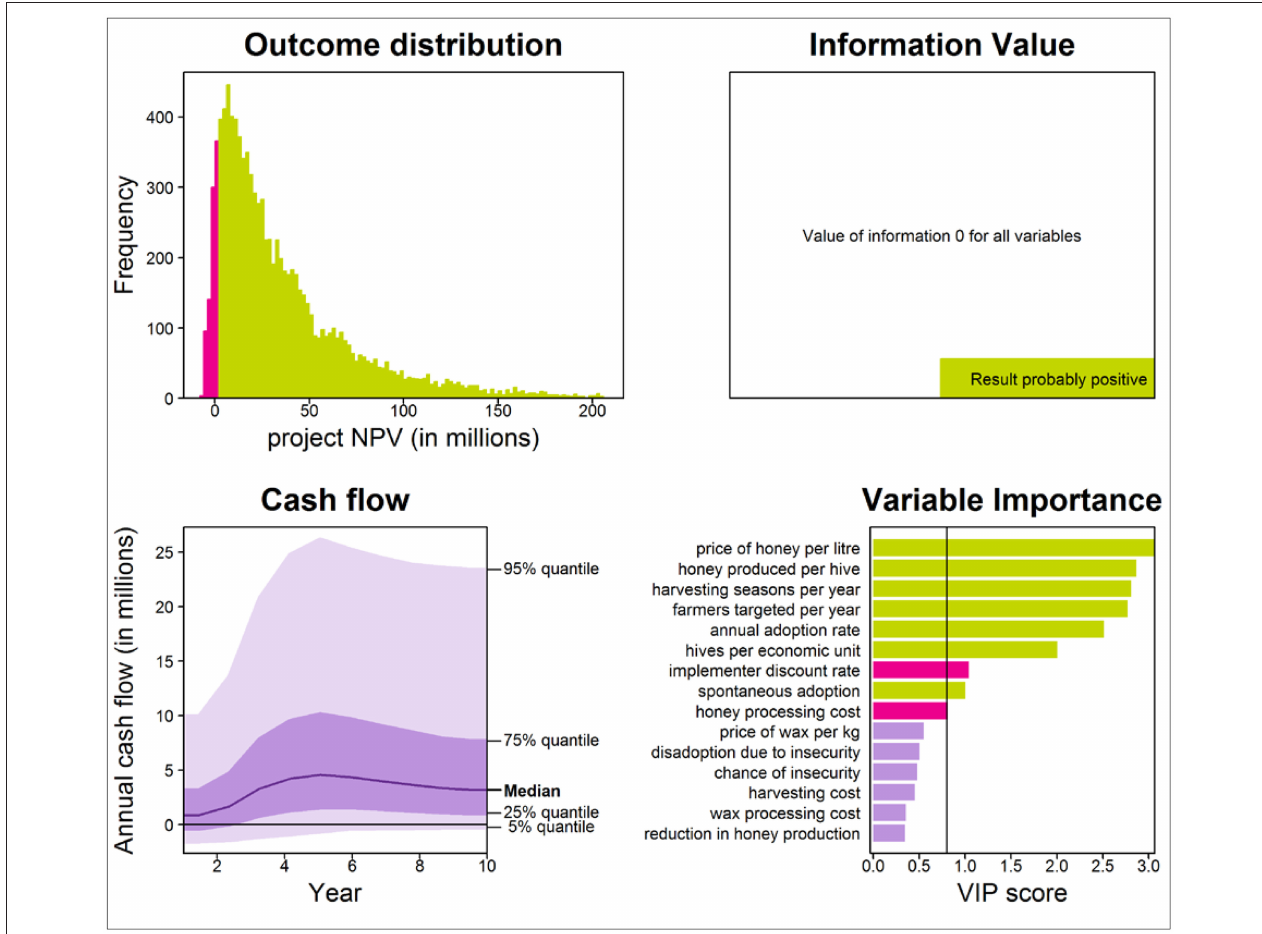
FIGURE 7 | Projected outcome distribution (top left), high-value variables (EVPI; top right), project cash flow (bottom left) and important variables (determined by PLS regression; bottom right) for the overall project in Awer, Kenya. Results were produced through Monte Carlo simulation (with 10,000 model runs) of project performance over 10 years. Red and green bars in the outcome distribution indicate positive and negative values, respectively. In the PLS plot, green bars indicate correlations of uncertain variables with the outcome variable, while red bars indicate negative